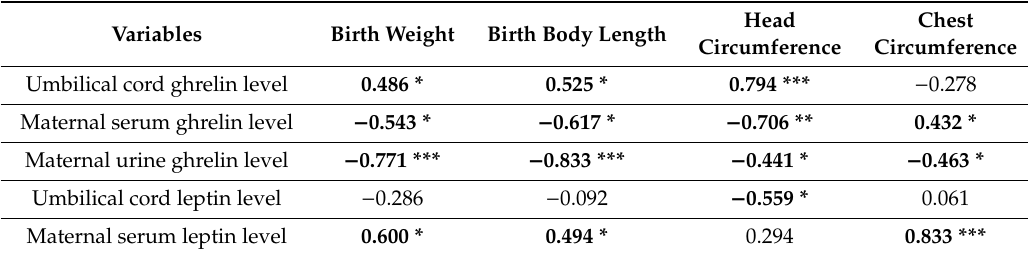
Table 4. Correlations of neonatal anthropometric measurements in the control group (Spearman’s rho coe ffi cient).